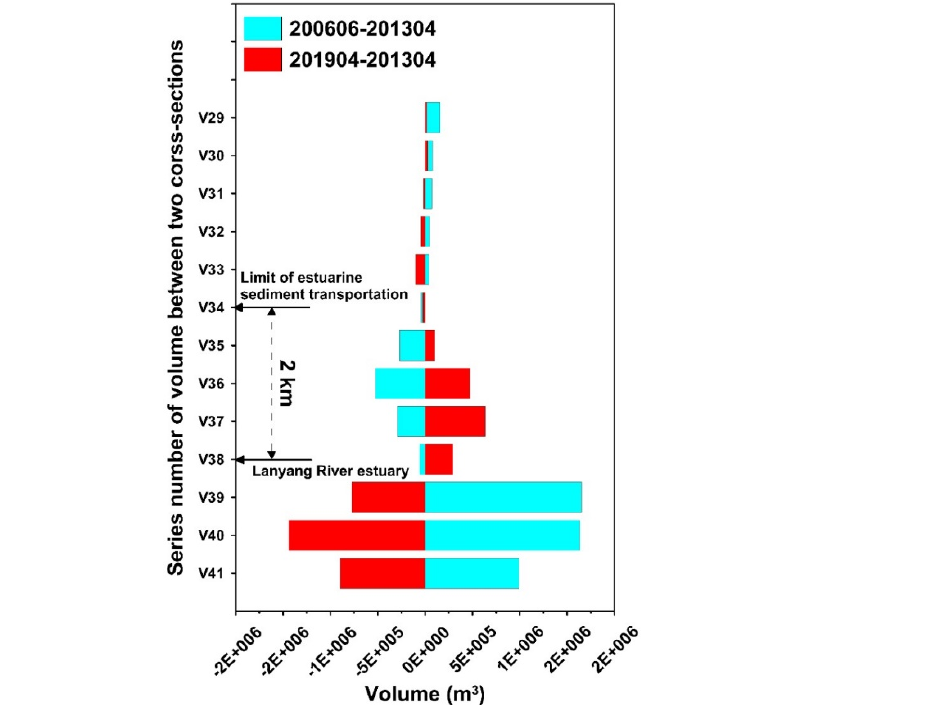
Figure 13. Net volume variations between erosion and accretion around the Lanyang River estuary (corresponding to V29 to V41 in Figure 11) during the period of June 2006 to April 2013 (cyan bar) and April 2013 to April 2019 (red bar).